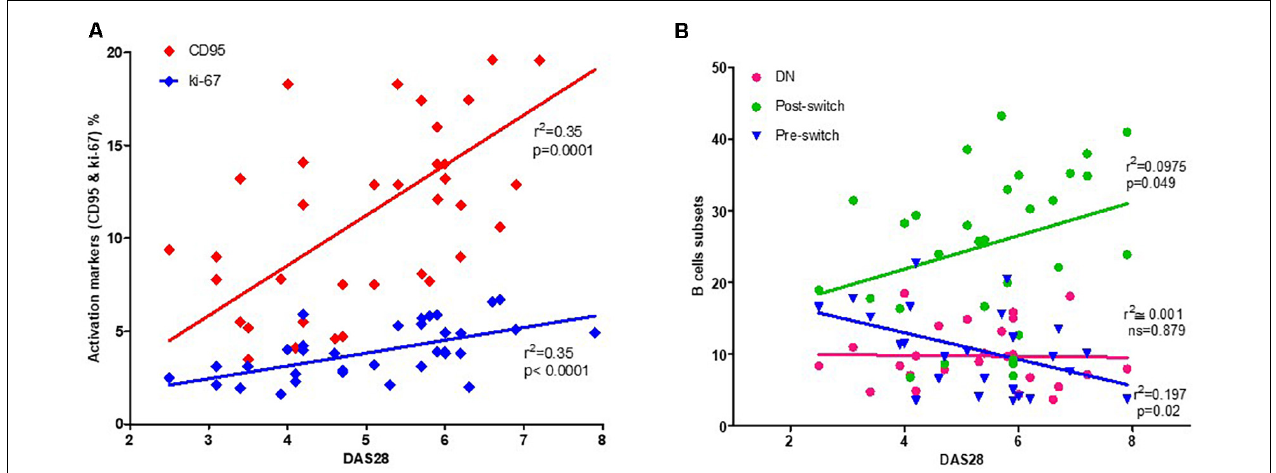
FIGURE 3 | Correlation between activated B cells and disease activity. A significant correlation can be observed between activated B cells, identified by their CD95+ or Ki-67+ expression, and DAS28 as a measure of RA disease activity (A) . Among B cell subsets, post-switch exhibits a positive correlation, pre-switch a negative correlation, while double-negative (DN) B cells fail to demonstrate any correlation with DAS28 (B) . The relationship between variables was evaluated using the Pearson linear correlation test. A two-sided p -value of < 0.05 was considered statistically